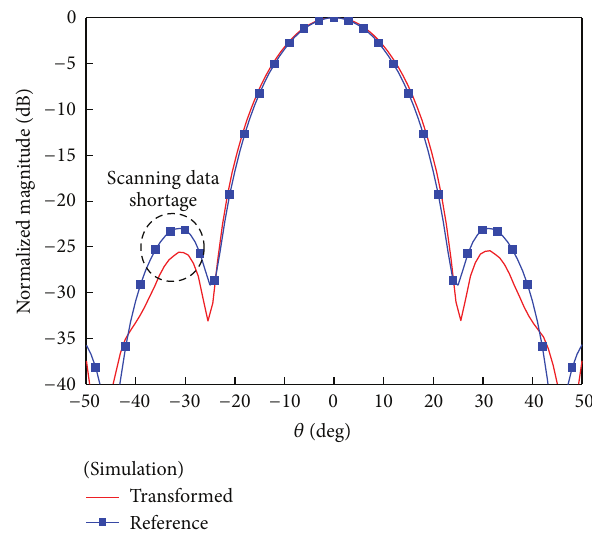
Figure 4: Transformed and reference far-field patterns from the simulation.